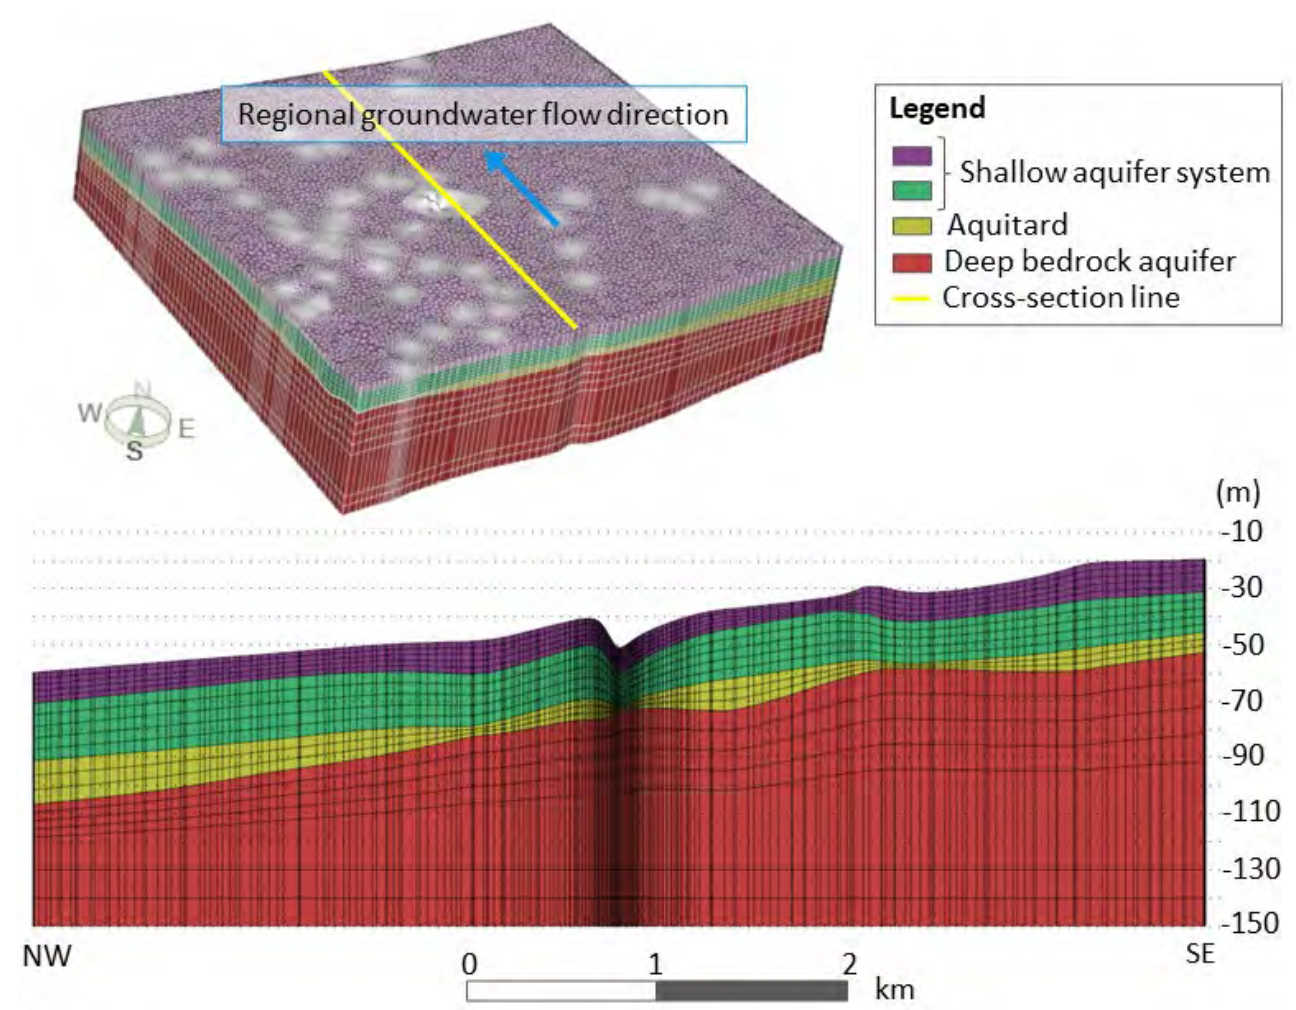
Figure 3. 3D view of the finite element mesh and a detailed NW–SE cross-section passing through the location of Building 3 (deep ATES system).